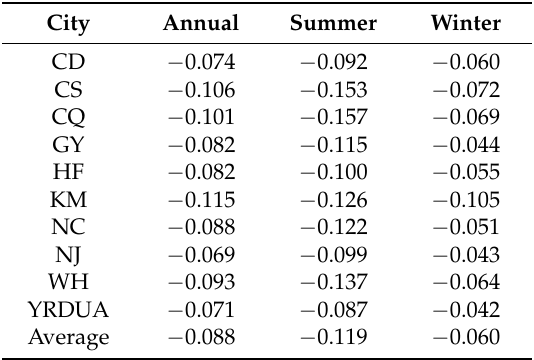
Table 3. 16-year averaged urbanization effects (UEs) on vegetation ( ∆ EVI) at 10 cities in Yangtze River Basin (YRB), China. The average data in the table is the mean value of 10